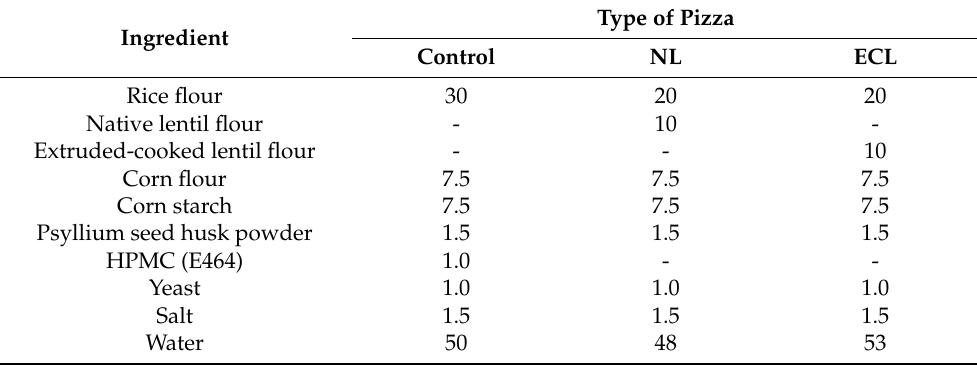
Table 1. Amounts of each ingredient (g/100 g of dough) used in the formulation of the experimen- tal samples of pizza crust, where either native (NL) or extruded-cooked (ECL) lentil flour partly substituted the rice flour. Type of Pizza Ingredient Control NL ECL Rice flour 30 20 20 Native lentil flour - 10 - Extruded-cooked lentil flour - - 10 Corn flour